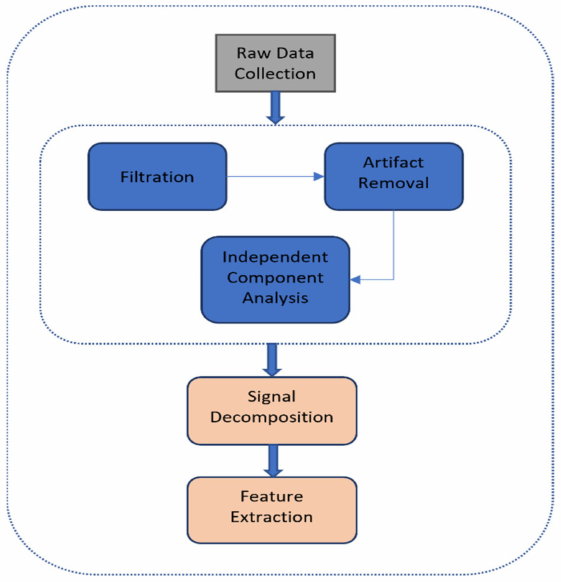
Figure 1. Experimental